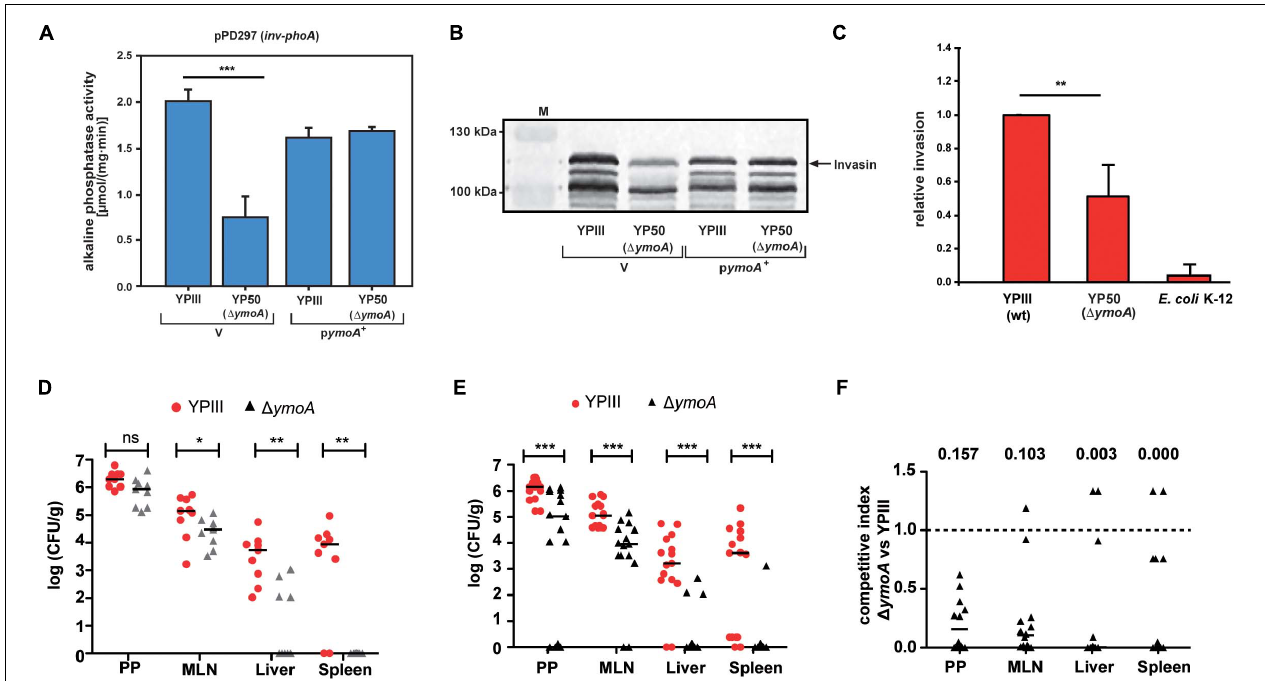
FIGURE 9 | Influence of ymoA on the virulence of Y. pseudotuberculosis . Y. pseudotuberculosis wild-type strain YPIII and the mutant strain YP50 ( (cid:49) ymoA ) harboring the inv-phoA fusion plasmid pPD297 and the empty vector control pACYC184 (V) or the ymoA + plasmid pAKH71 were grown overnight in LB medium at 25 ◦